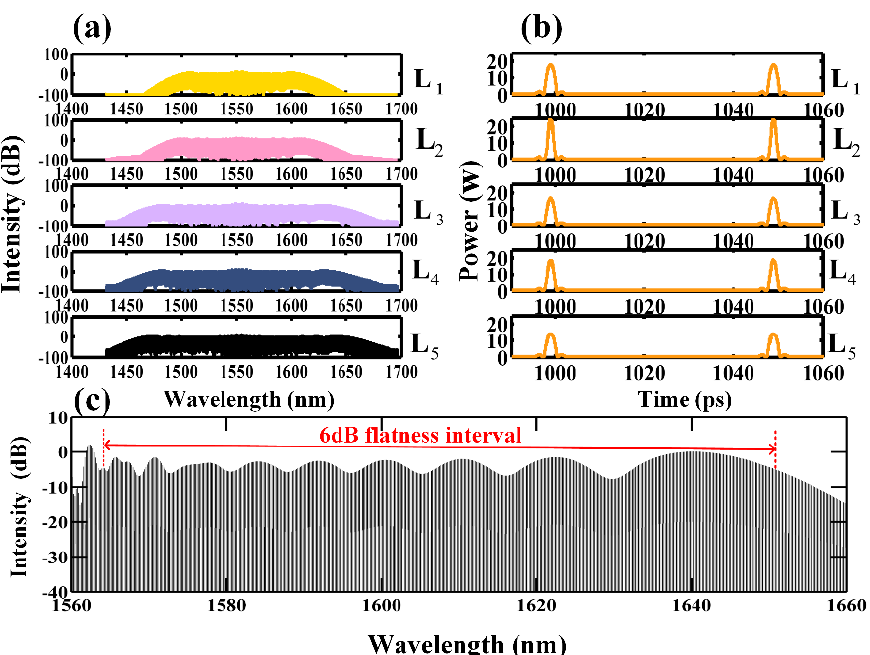
Figure 8. ( a ) The output spectra at different stages of CSAD-TMF; ( b ) the evolution of pulse profiles at different stages of CSAD-TMF; ( c ) the enlarged image of the final output spectrum over 1560–1660 nm.